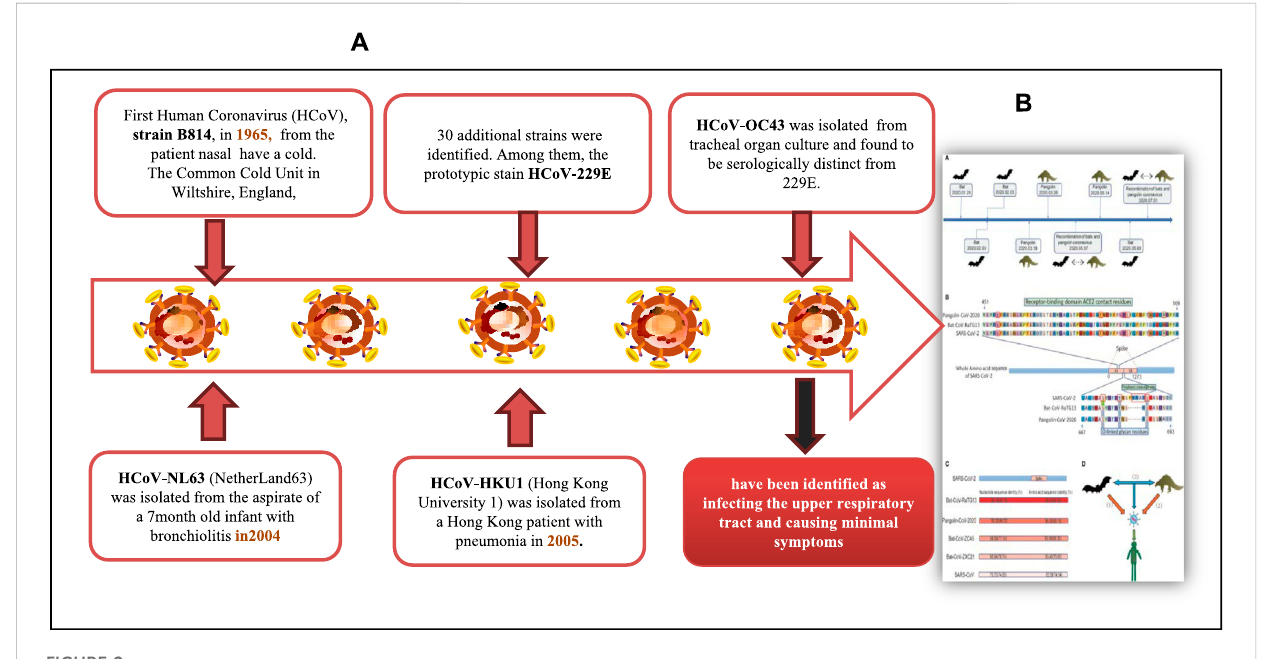
FIGURE 2 (A) COVID-19 Pathogenesis and (B) A member of a wide family of encapsulated, non-segmented, positives (+) RNA viruses ’ sense single-stranded that can be found in dogs, camels, bats, and cats. (Adapted from Chen et al.,